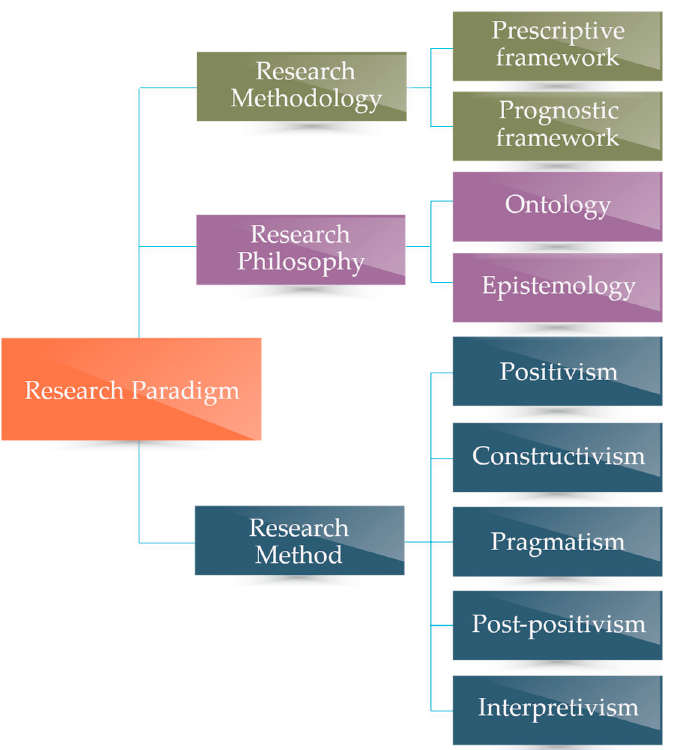
Figure 3. An overview of the research process hierarchy recommended for research and development of sustainable energy policies.